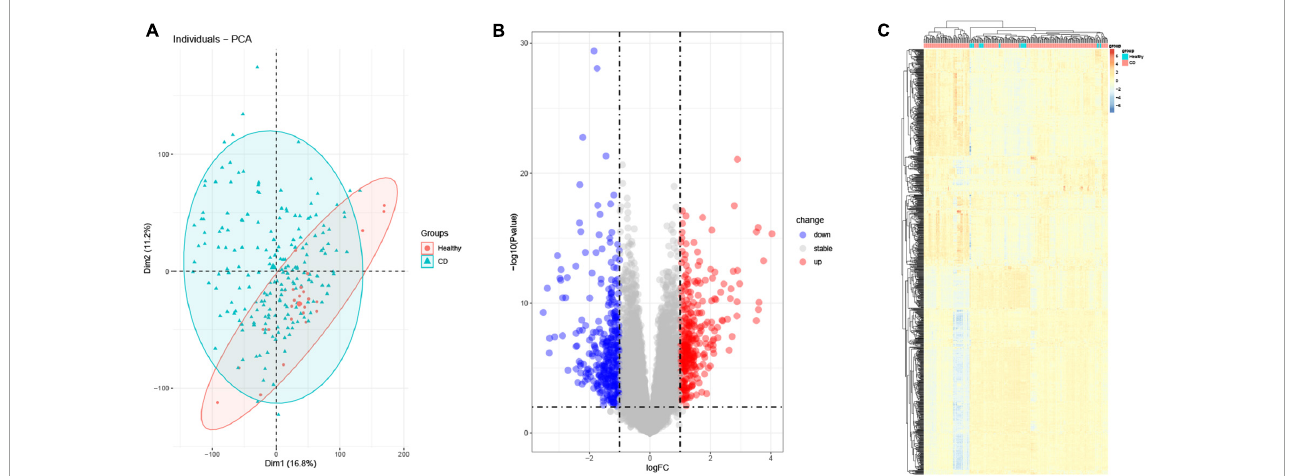
FIGURE1 Differential gene analysis (DEG). (A) Principal component analysis (PCA). Red represents normal samples, blue represents CD samples. (B) Volcano plot differential gene analysis of GSE186582, red represents up-regulated genes and blue represents down-regulated genes. (C) Heat map analysis of differential genes.